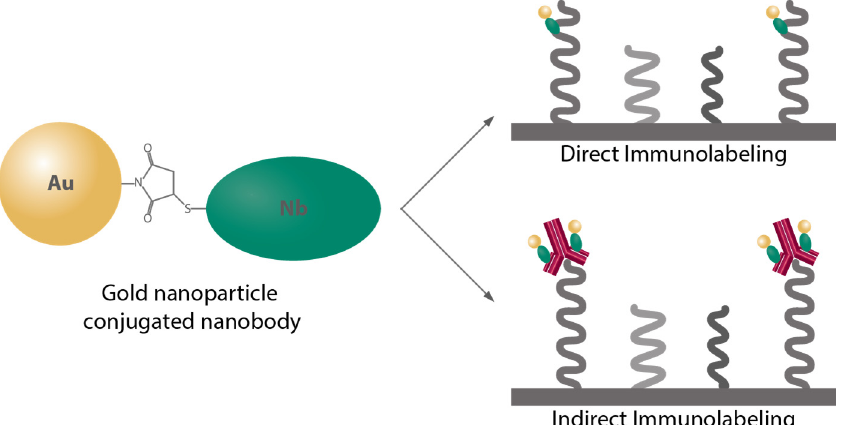
Figure 1. Au nanoprobes for revealing proteins of interest (POIs) via either direct or indirect immunolabeling strategies. Direct immunolabeling is obtained by using an Au nanoprobe detecting endogenous POIs. For indirect immunolabeling, the POIs are first recognized by a specific primary mouse antibody, which is then revealed by an Au anti-mouse secondary nanobody.